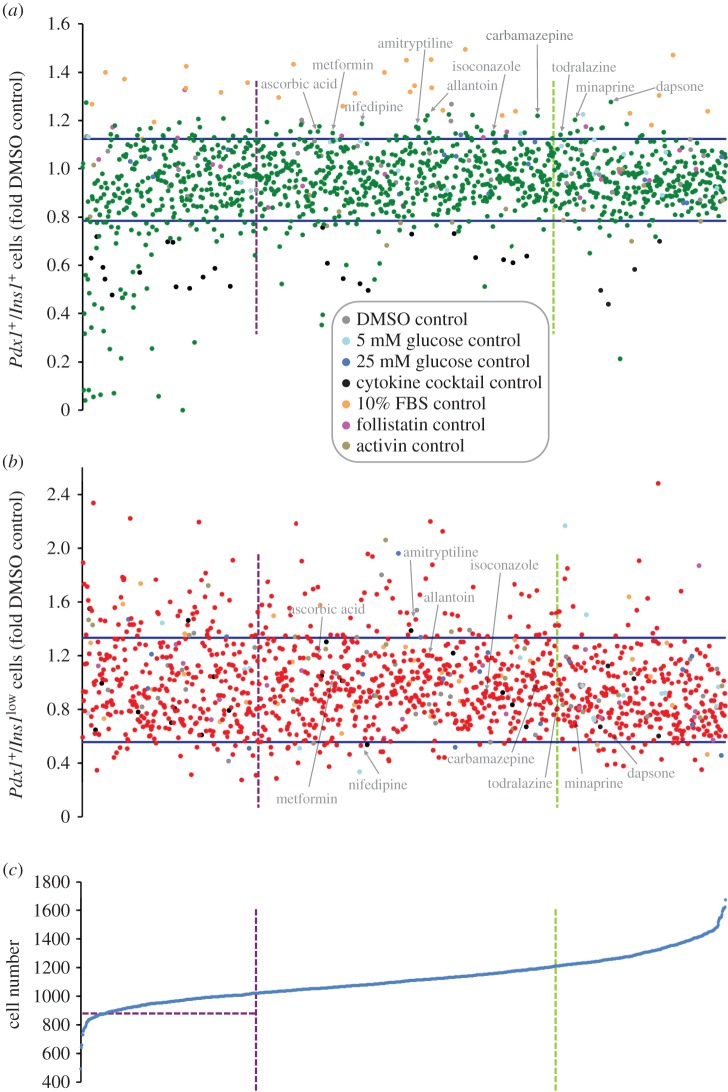
Effects of drugs on Ins1 promoter activity, Pdx1 promoter activity and cell proliferation/survival. (a–c) Data for the Prestwick library drugs for all three parameters is shown ranked according to their effects on increasing total cell number (bottom panel). Factors outside of the arbitrary purple and green vertical lines were deemed to have potential effects on cell viability and/proliferation. Drugs that fell outside of the blue lines in (a,b), which show 2xMAD (median absolute deviation), were then assessed as possible hits. Hits were chosen for their effects on several outputs such as inducing β-cell maturation by increasing the relative number of mature Pdx1+/Ins1+ cells (top) and concomitantly reducing the relative number of immature Pdx1+/Ins1low cells (middle). Positive controls are marked in orange.